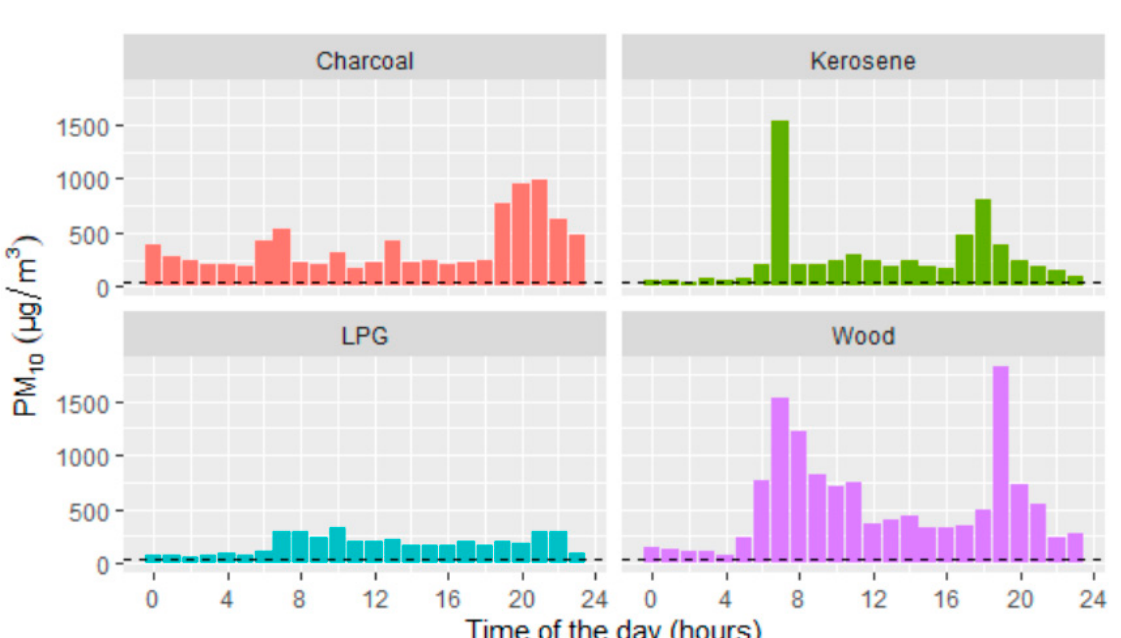
Figure 4. Graph showing hourly variation of PM 10 grouped by fuel type. Dotted line plotted at 45 µg/m 3 , which is the mean 24 h WHO limit.